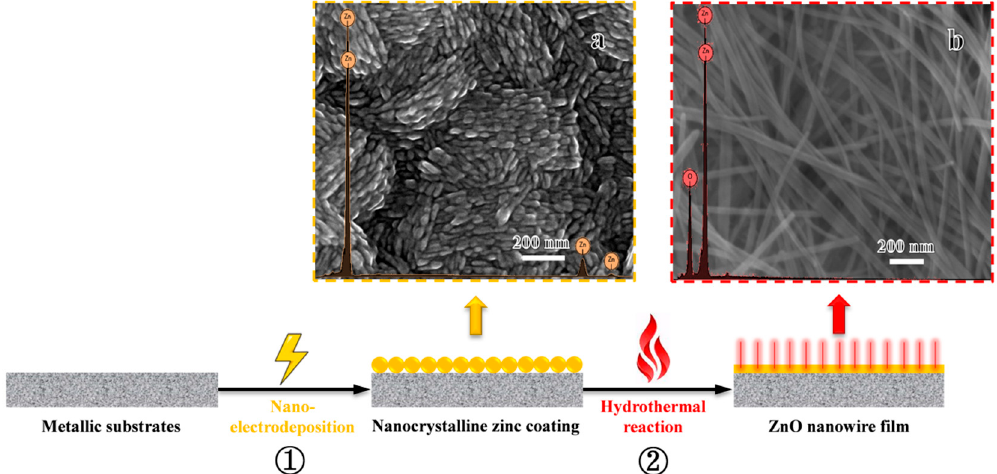
Figure 1. Schematic illustration of the synthetic procedure with scanning electron microscope (SEM) images and energy dispersive X-ray spectroscopy (EDXS) spectra of nanocrystalline zinc coating ( a ) as well as ZnO nanowire film ( b